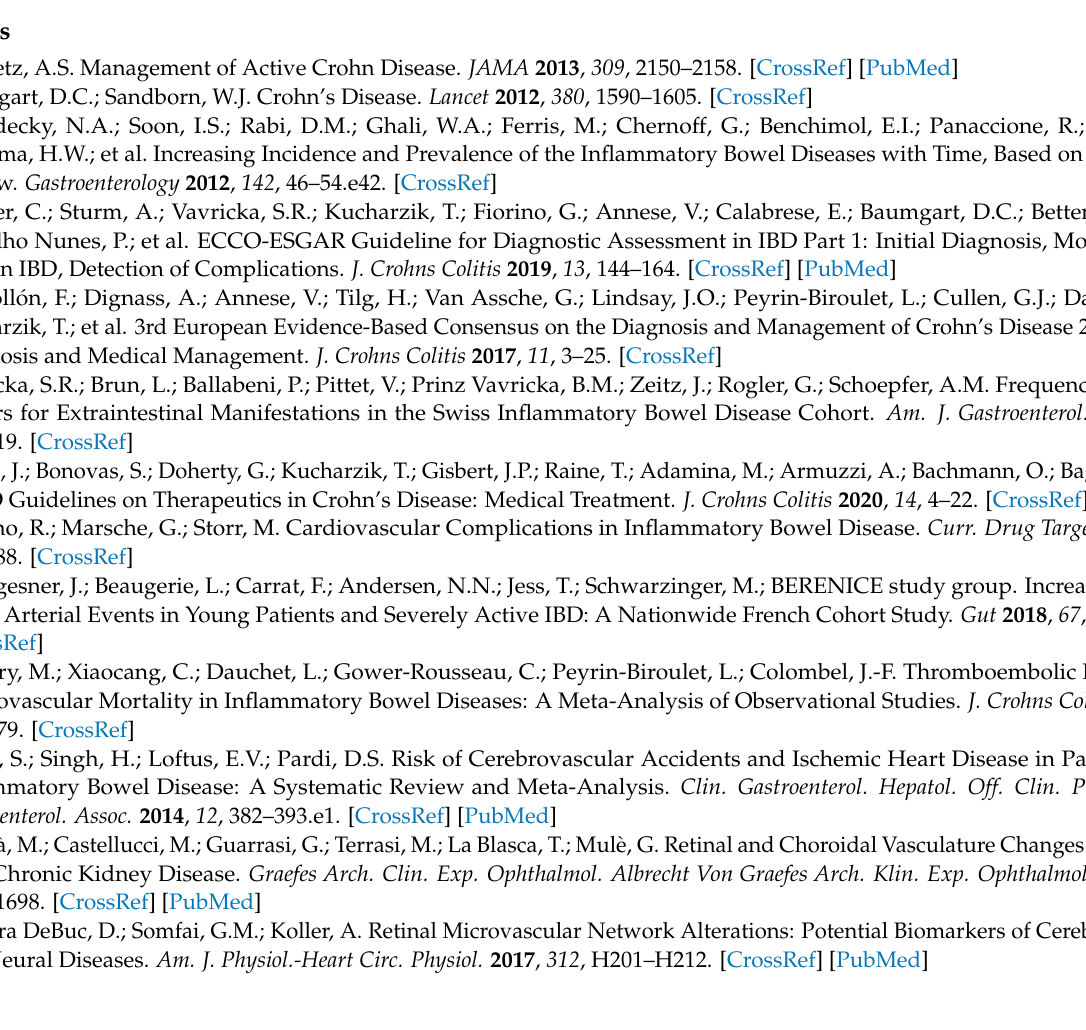
Table S2: Age-, sex- and tobacco use-adjusted analysis of covariance: association of the main mi- crovascular variables with deep activity status ( n =